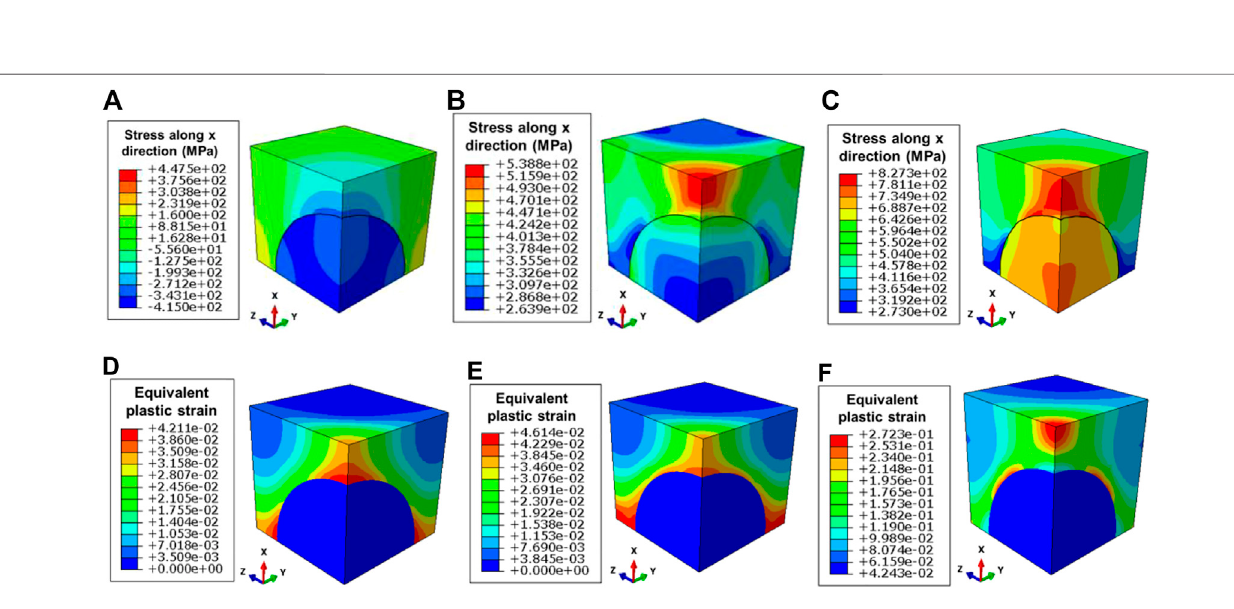
Frontiers in Materials |